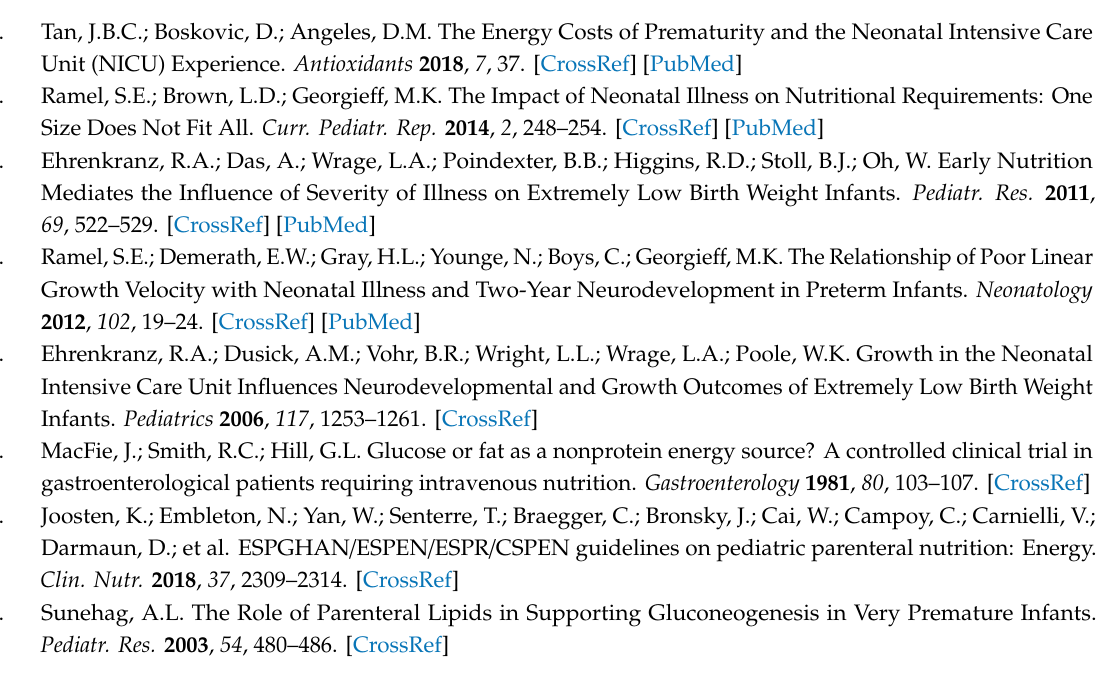
Table S1: Composition of the MCT / ω -3 PUFAs- and the SO-IVFE, Table S2: Nutrient and mineral intake via enteral and parenteral routes in the SO-IVFE and the MCT / ω -3 PUFAs group at the endpoint of intervention (day